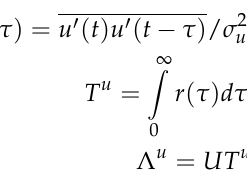
Figure 6. Pre-multiplied spectral difference of the velocity fluctuations between the HT and LT cases, ∆ ( f Φ Φ − f Φ u ) = f HT LT , at various streamwise and spanwise locations. ( a ) y / R ( c ) y / R = 1; ( d ) y / R =